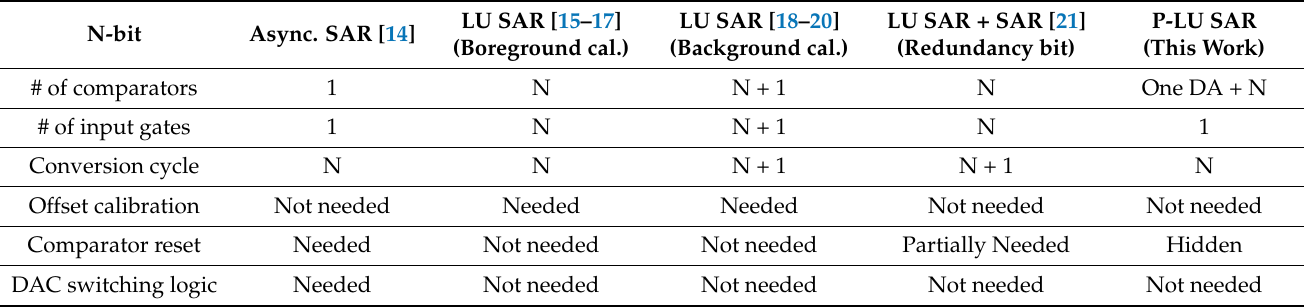
Table 1. Comparison for SAR ADC architectures.